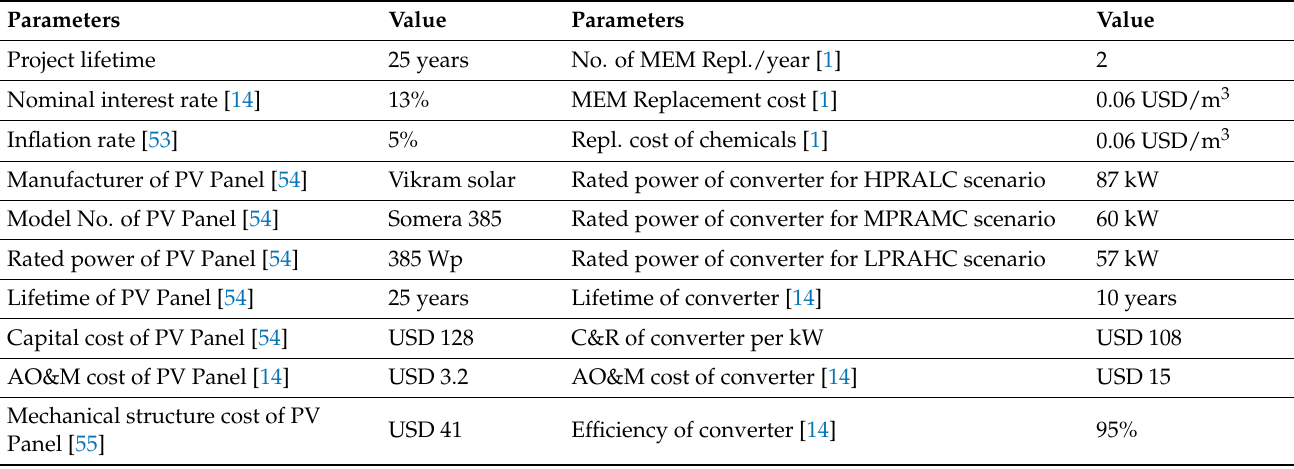
Table 7. Technical and cost values of the